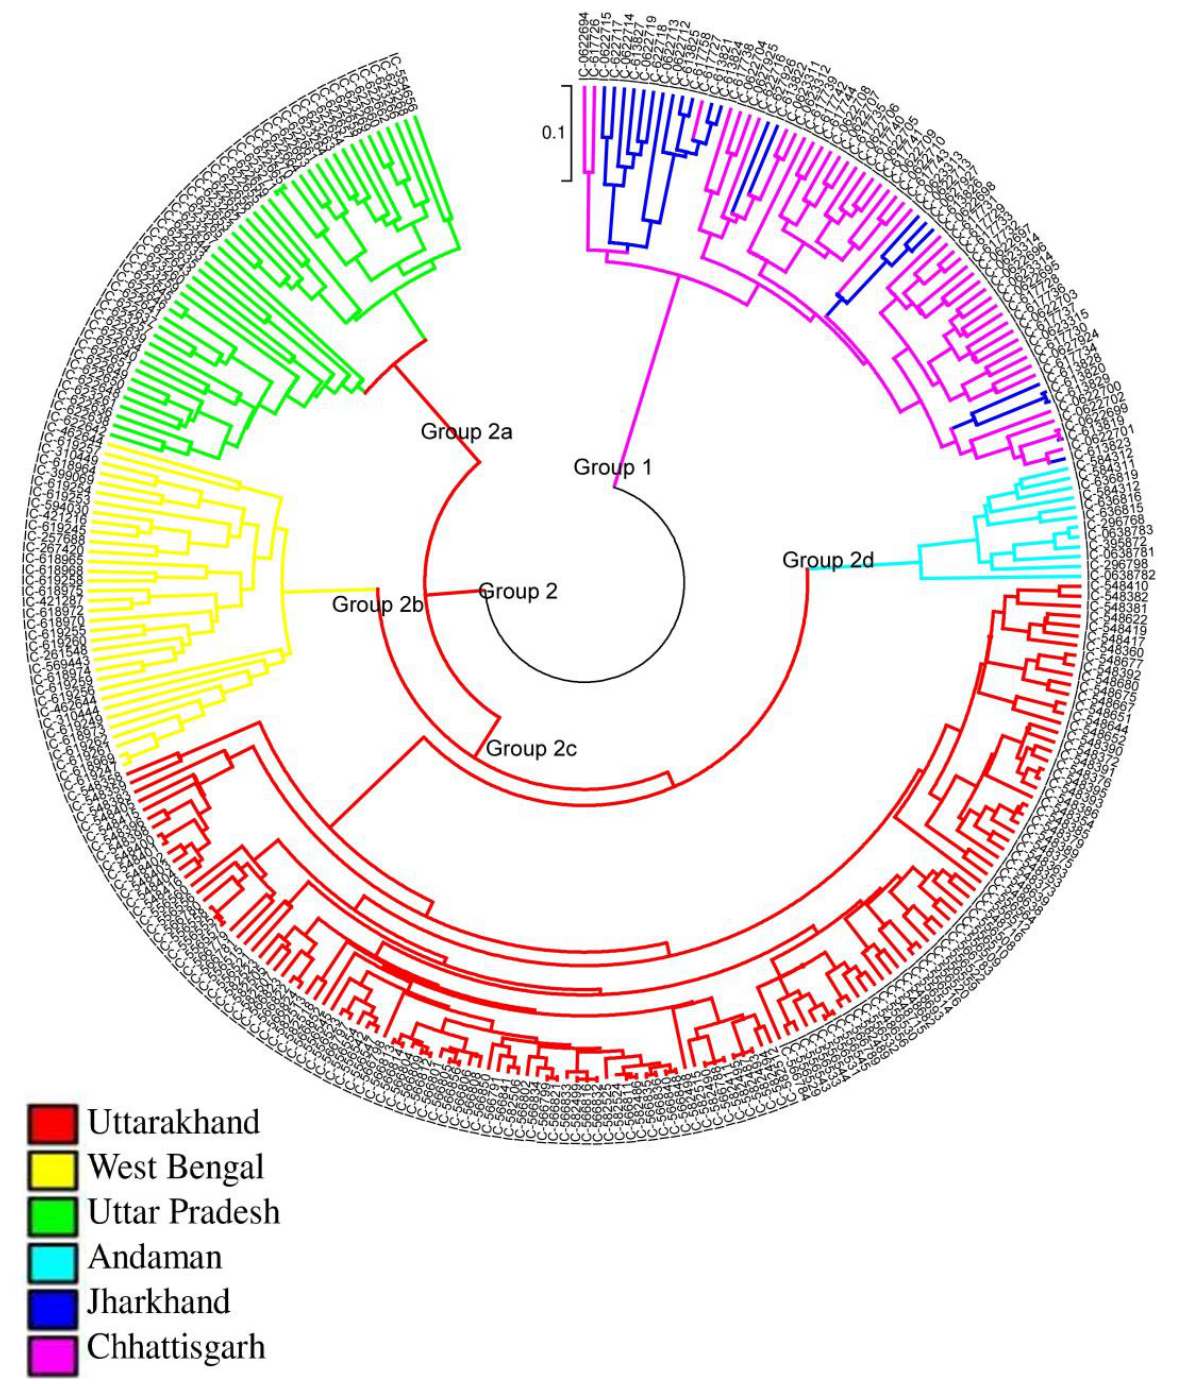
Figure 2. Neighbor-joining tree of 298 rice landraces using SSR markers.